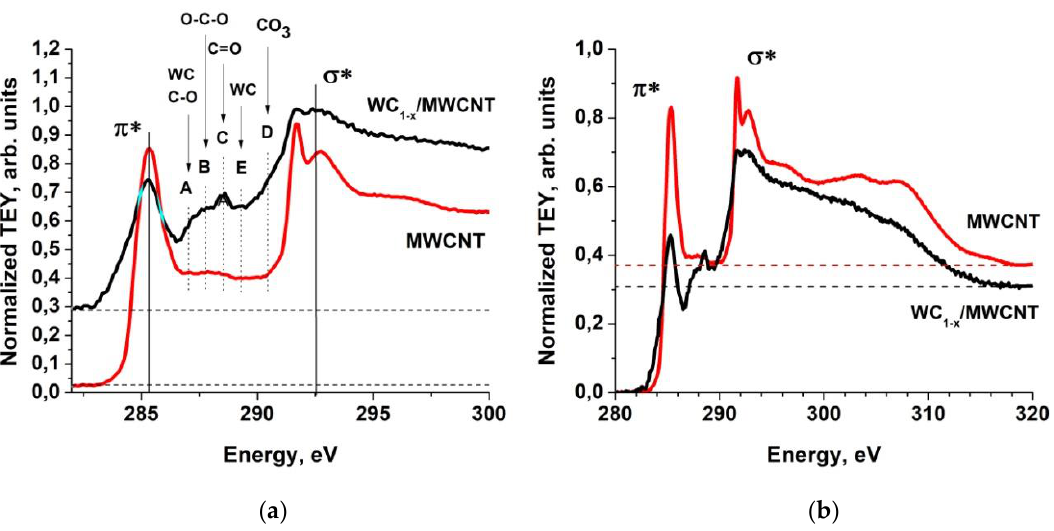
Figure 7. Normalized TEY signal of MWCNTs (red) and nanocomposite sample 2 (black) in arbitrary units in near the Near Edge X-ray Absorption Fine Structure (NEXAFS) C1 absorption edge ( a ). The arrows indicate the fine-structure elements energy positions of the carbon oxygen’s [68,69] and WC [70–73] near the NEXAFS C1 edge. Dash-dotted lines indicate the partial C1 absorption cross sections isolation. Partial C1s normalized TEY signal of MWCNTs (red) and nanocomposite sample 2 (black) in arbitrary units ( b ). The dashed lines indicate the absorption levels in the continuum.